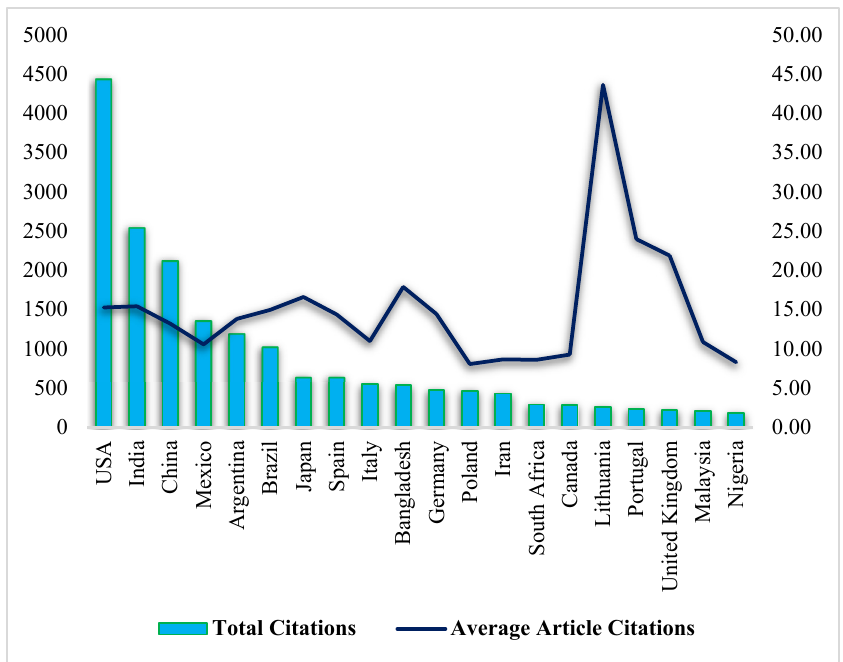
Figure 3. Countries’ citation metrics on amaranth-related publications between 2011 and 2020.